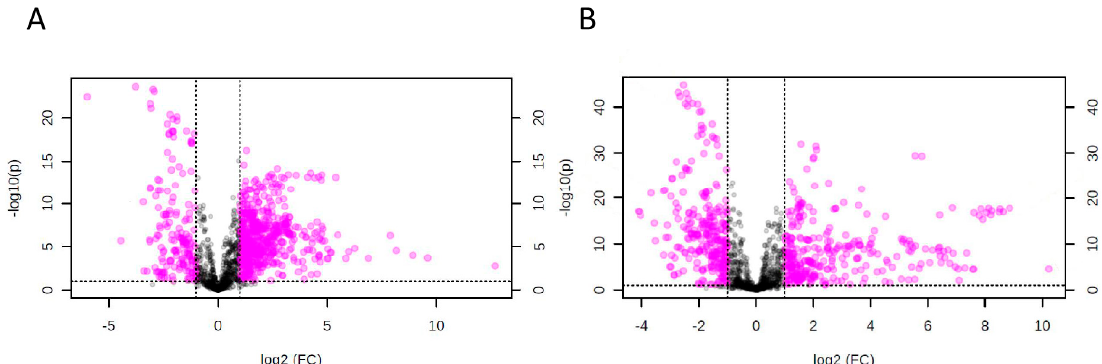
Figure 2. Volcano Plot, using fold-change (FC) >1.5 and p -values cut-off <0.05 using Student’s t -test. The statistical analyses were performed for comparison between melioidosis and bacteremia patients in ( A ) positive mode as well as melioidosis patients and controls without active infection in ( B ) positive mode.